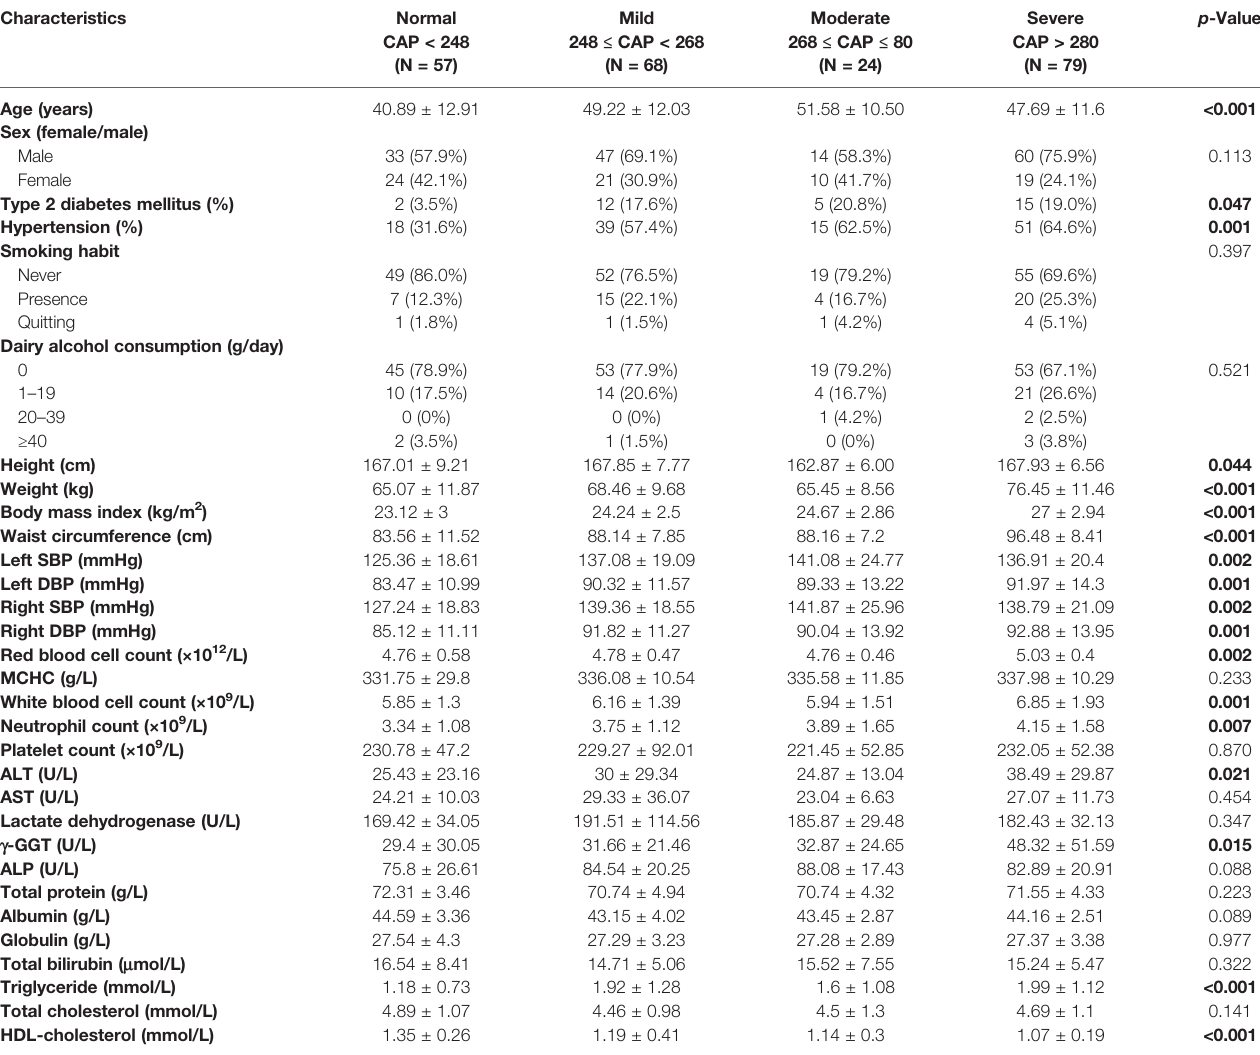
TABLE 4 | Characteristics of different degrees of MAFLD patients (CAP subgroup).